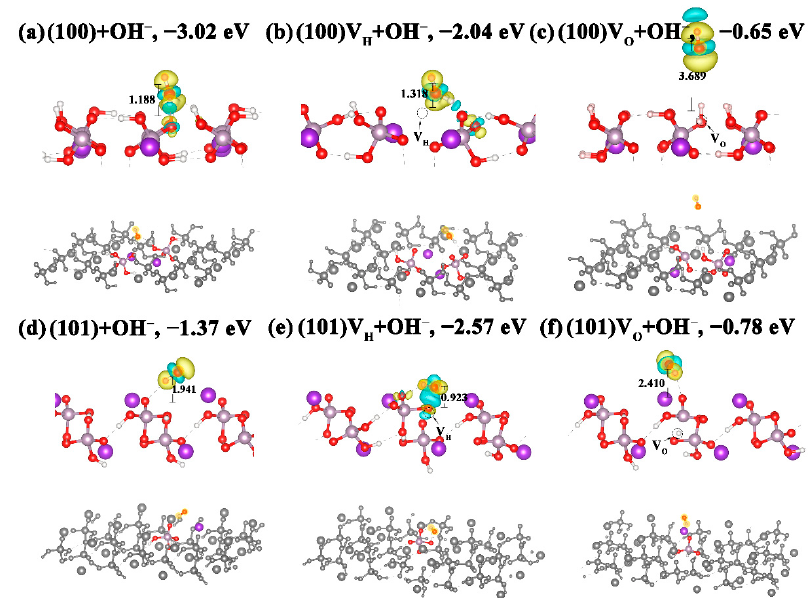
Figure 6. Local and overall structures as well as the charge-density difference maps of OH − adsorbed on (100) and (101) surfaces. ( a ) Perfect (100) surface; ( b ) (100) surface with a V H defect; ( c ) (100) surface with a V O defect; ( d ) perfect (101) surface; ( e ) (101) surface with a V H defect; ( f ) (101) surface with a V O defect. Yellow and blue regions represent electron accumulation and depletion, respectively. The corresponding adsorption energy is listed at the top of each figure.